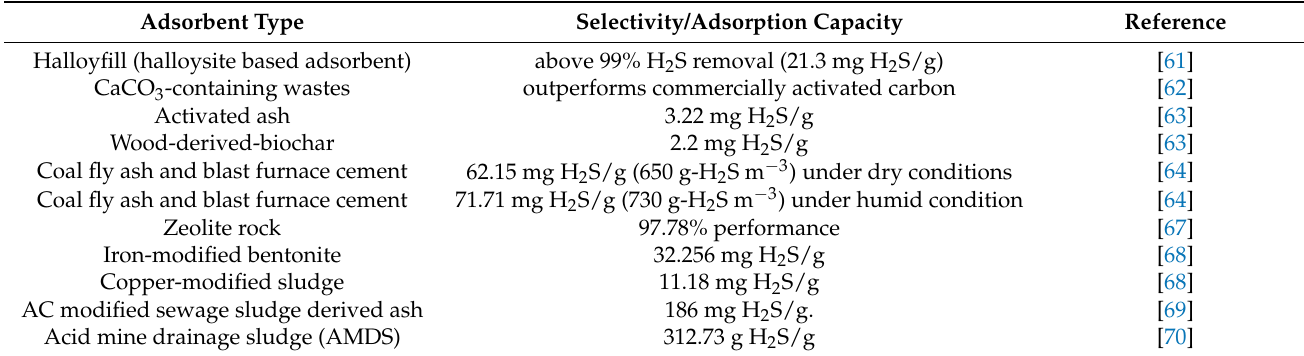
Table 7. Studies on the waste-based